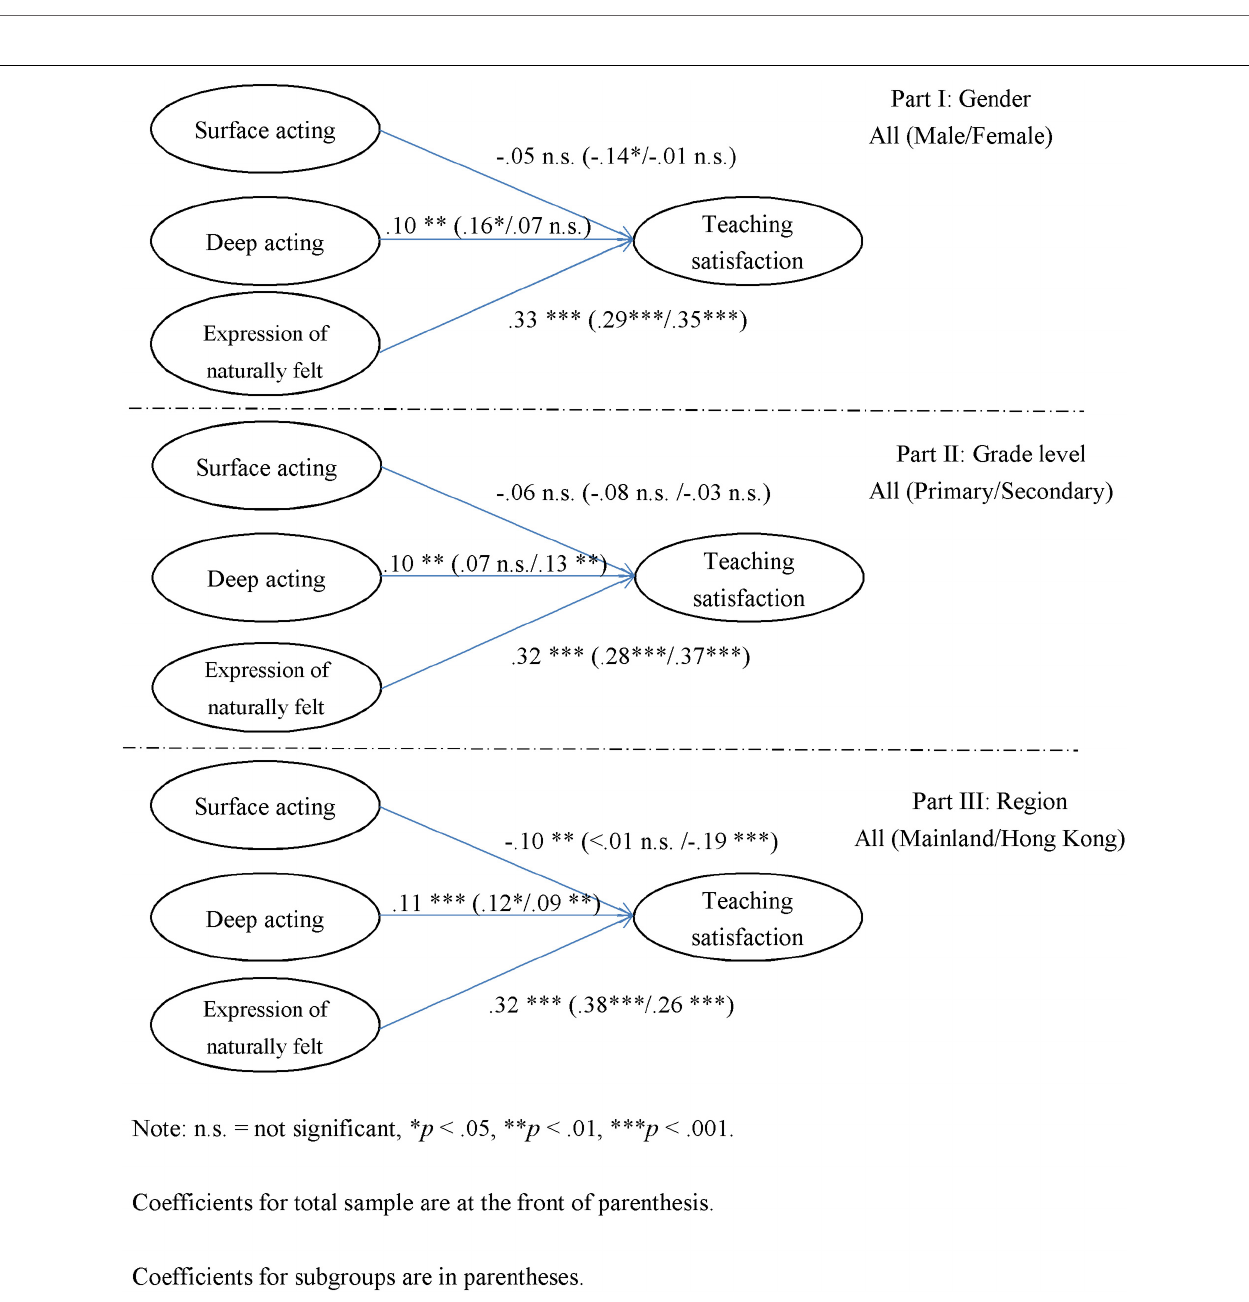
FIGURE 1 | The results of structural equation